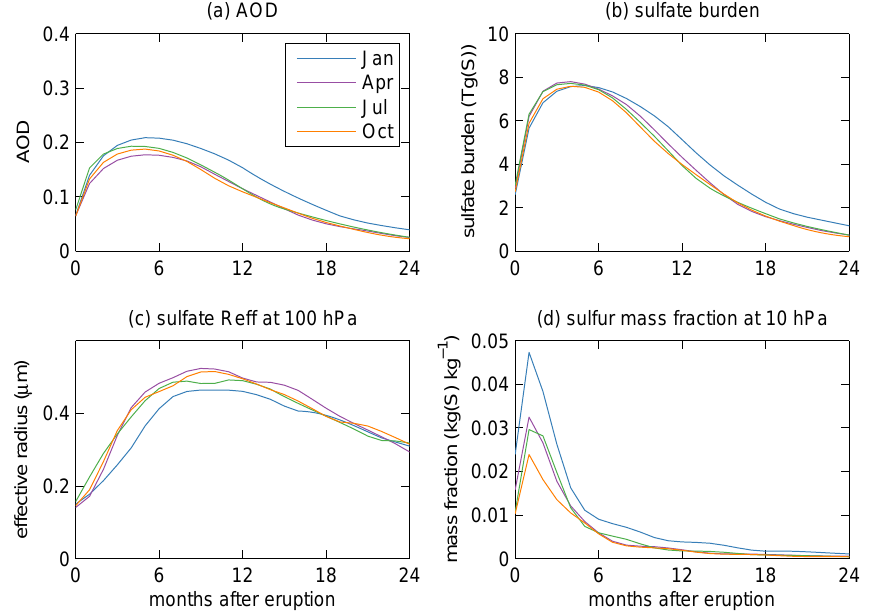
Fig. 6. Timeseries of (a) global mean AOD, (b) global sulfate mass burden, (c) global mean sulfate aerosol effective radius at 100hPa, and (d) global mean sulfate mass fraction at 10hPa.